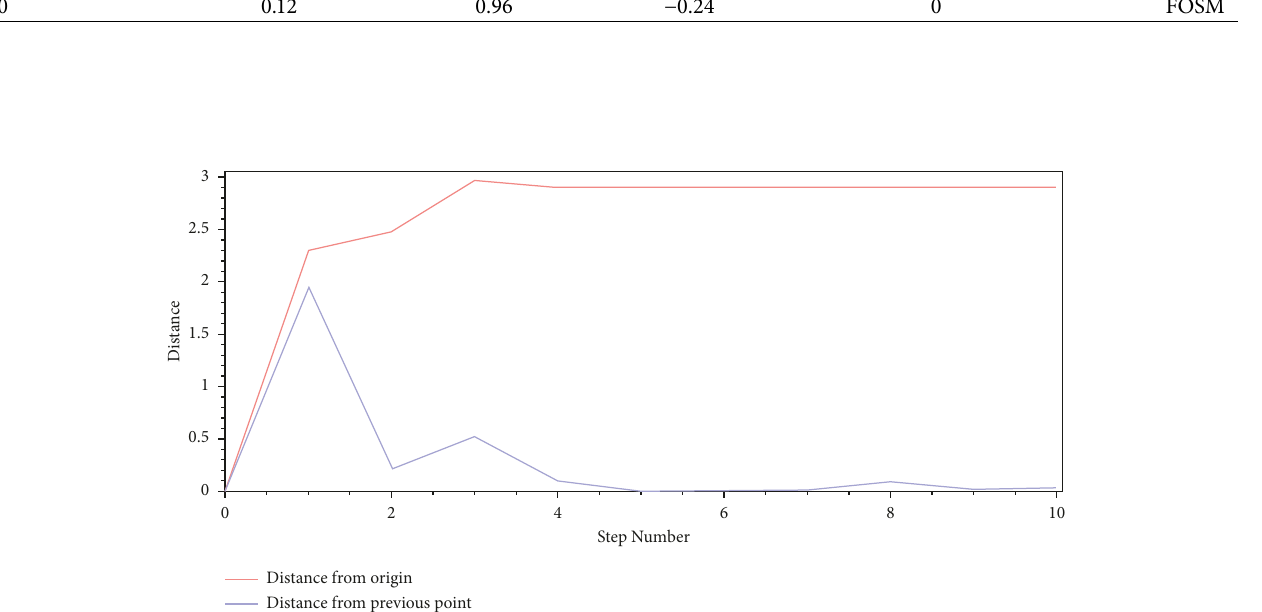
Figure 13: Convergence diagram of FORM analysis for type IV frame in RT program.